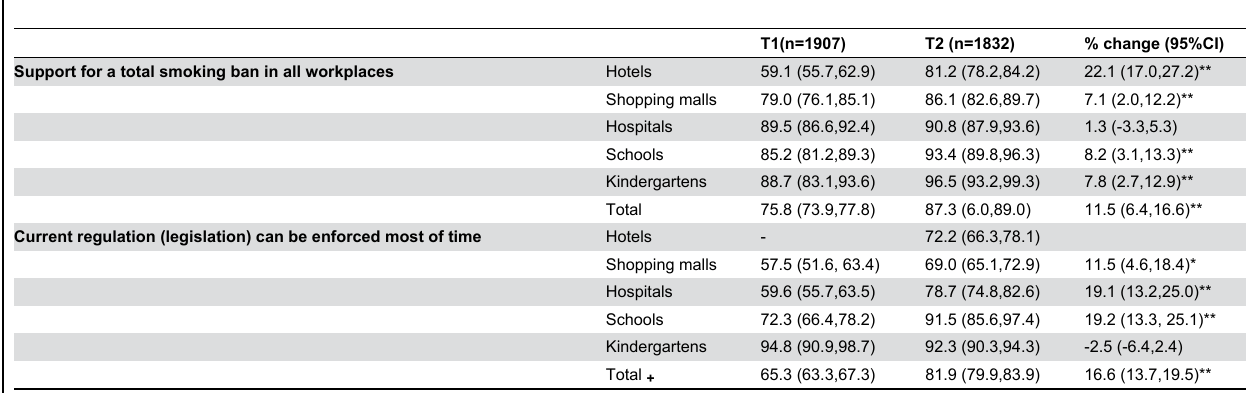
Table 2. Support for a total ban and evaluation of compliance to current regulation